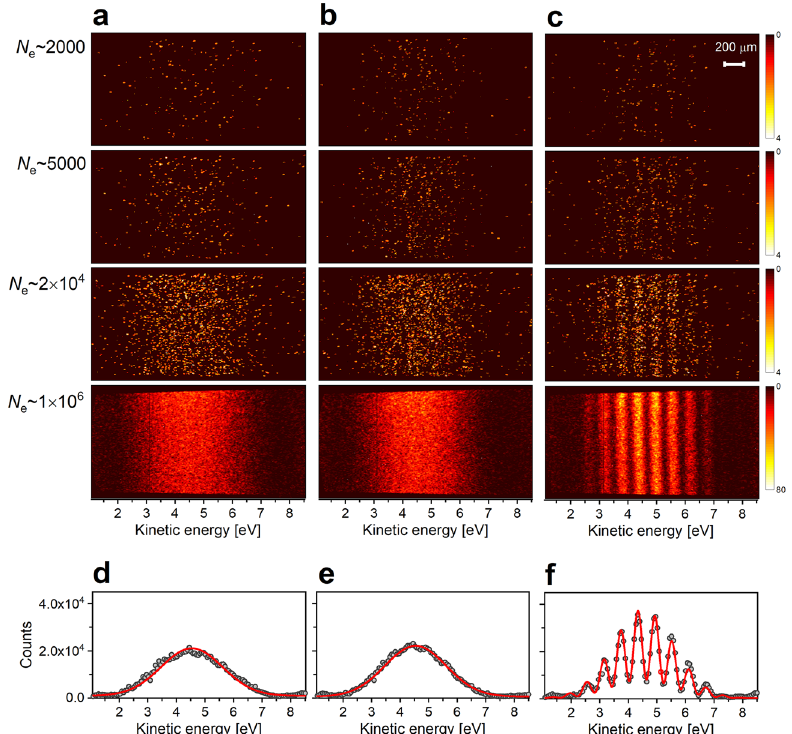
Figure 2. One-by-one detection of single-photoelectrons. ( a – c ) CCD images of photoelectrons observed for radiation from ( a ) the upstream undulator, ( b ) the downstream undulator, and ( c ) the tandem-undulator. The phase shifter current was kept constant during the measurements. The total number of detected electrons are shown at the left side of the panels ( a ). The color bar ranges from 0 to 4 electrons in the upper three panels, and from 0 to 80 electrons in the images obtained at 1 × 10 6 electrons. ( d – f ) One-dimensional distributions obtained by projecting the electron intensities in the images of 1 × 10 6 electrons onto the energy axis. The interference fringes were fitted by a model curve using Eq.